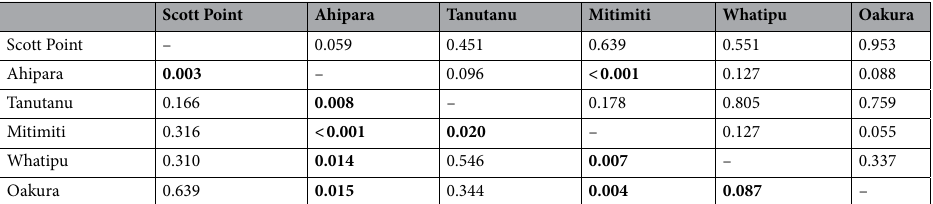
Table 2. Significance ( P -values) levels for differentiation between each site pair across all loci (Fisher’s method). P -values for allelic differentiation across all 10 loci below the diagonal and for genotypic differentiation across all 10 loci above the diagonal. Values in bold are statistically significant after correction for multiple testing. Sites are arranged north to south.